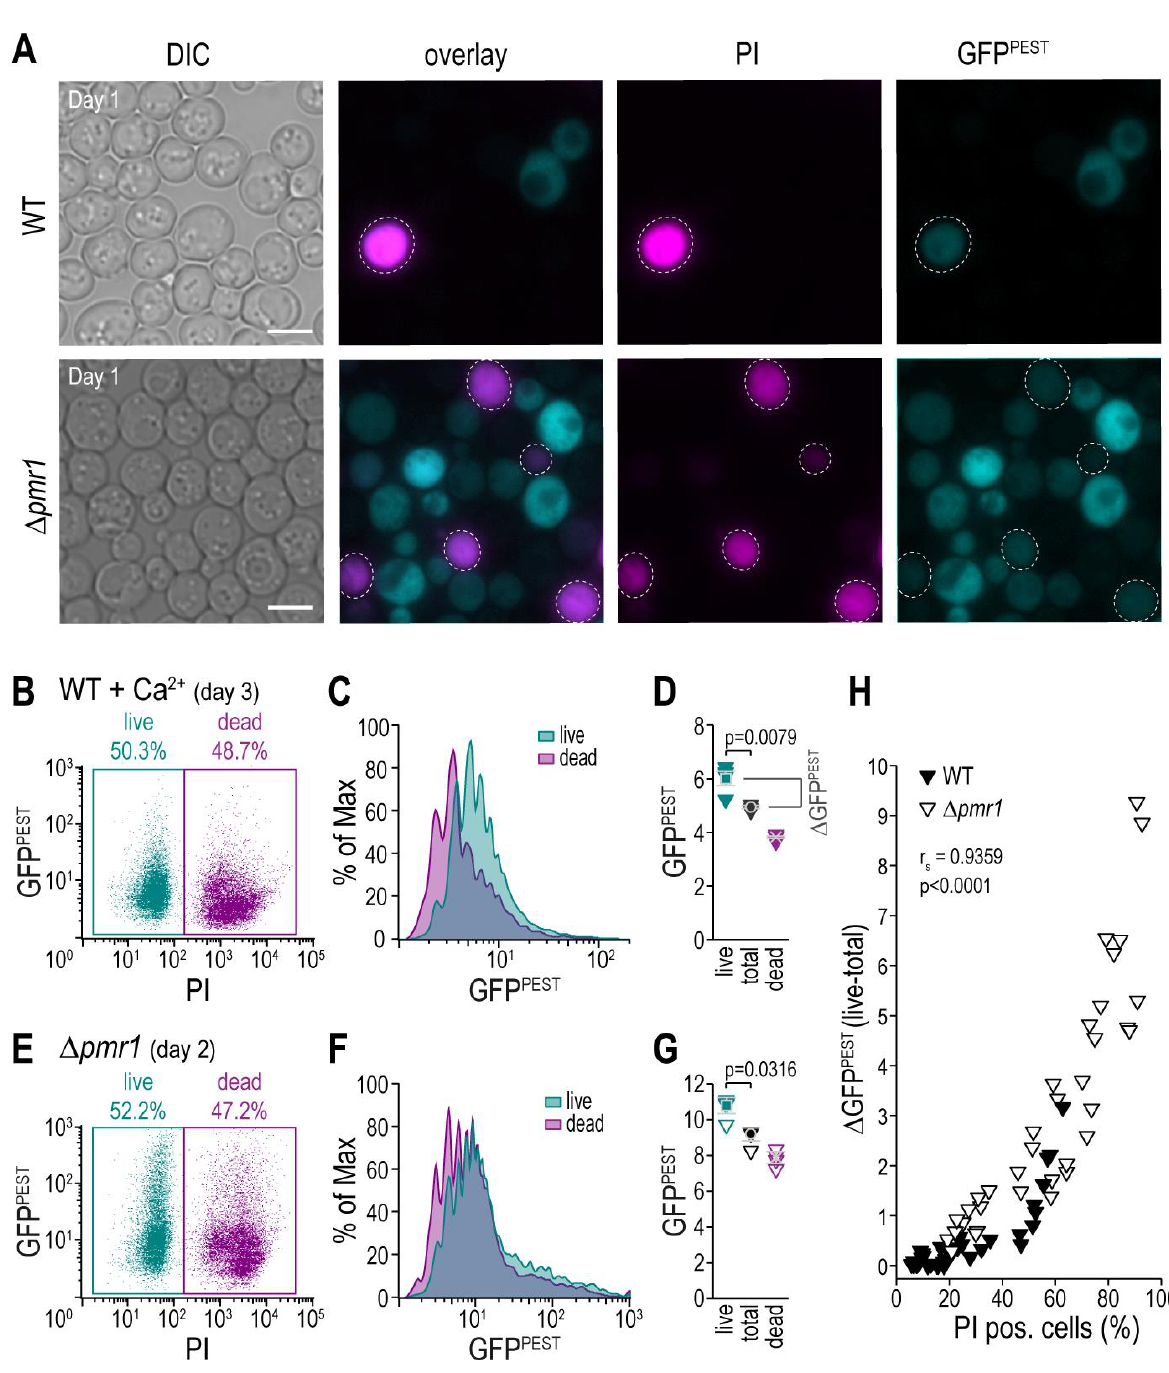
FIGURE 4. A fluorescent reporter for CN activity allows for simultaneous exclusion of dead cells via flow cytometry. (A) Representative micrographs of wild type and  pmr1 cells equipped with pAMS366-4xCDRE-GFP PEST and stained with propidium iodide (PI) to indicate loss of plasma membrane integrity and thus cell death. Scale bar = 5 µm. (B-G) Flow cytometric analysis of PI-stained aged wild type cells treated with Ca 2+ for 1 h as well as  pmr1 cells equipped with pAMS366-4xCDRE-GFP PEST . Respective dot plots (B, E), histograms of GFP PEST intensities of PI negative (live) and PI positive (dead) cells (C, F) and mean GFP PEST intensities of total, live and dead cell populations (D, G) are shown. (H) Simultaneous quantification of cell death via PI staining and CN activity in cells equipped with pAMS366-4xCDRE-GFP PEST . Wild type and  pmr1 cells of different age and upon treatment with different concentrations of Ca 2+ were analyzed, and the difference of GFP PEST fluores- cence intensity between total and live cell populations (∆GFP PEST (live-total)) was plotted against the percentage of PI positive